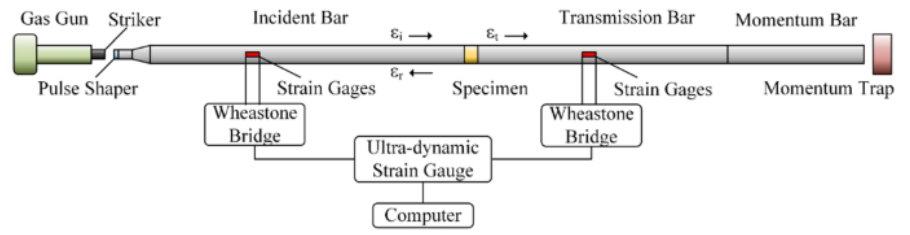
Figure 25. General view of SHPB system (reprinted from Ref. [89]).